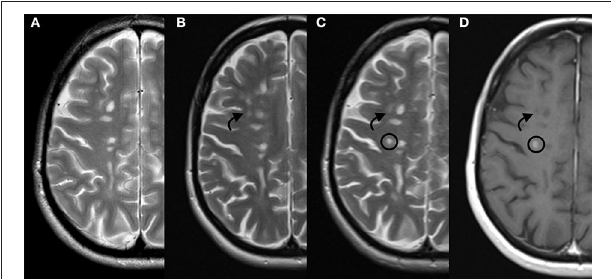
FIGURE 1 | Patient’s disease progression on MRI. From the left to the right: T2 weighted sequences respectively on June 2018 (A) , February 2019 (B) , and July 2019 (C) , and; contrast enhanced T1 weighted sequence on July 2019 (D) . Arrow indicates a new demyelinating lesion and circle indicates a new demyelinating lesion presenting contrast enhancement. MRI, magnetic resonance